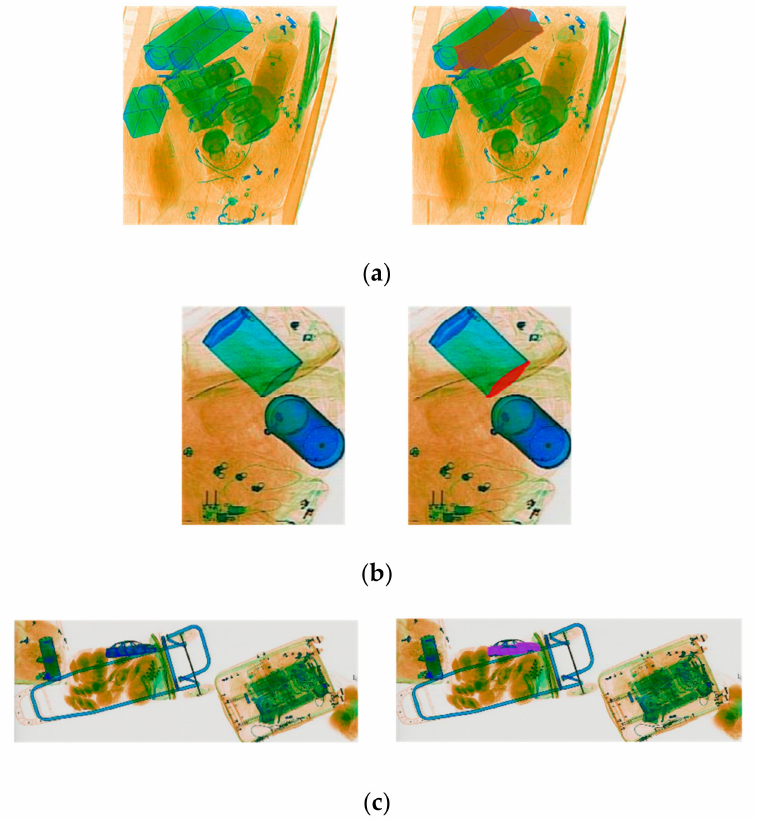
Figure 11. Exemplar images of unsuppressed detections. Images are wrongly predicted to contain ( a ) knife, ( b ) knife, and ( c ) gun. Images on the right are the inputs, and images on the left are the outputs with overlayed